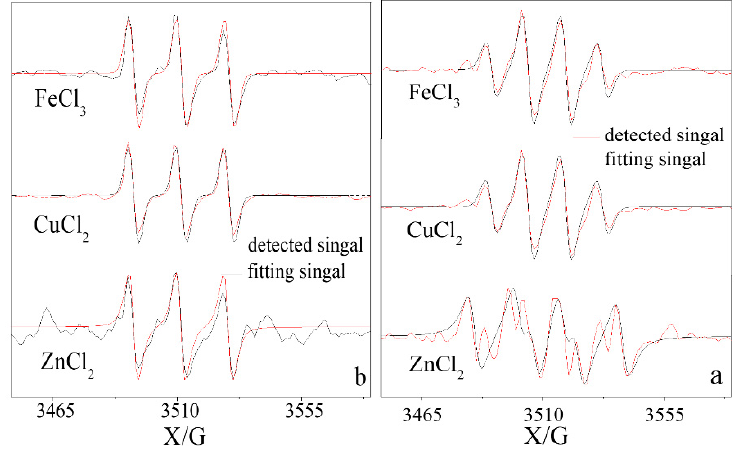
Figure 4. ESR spectra for 0.1 mM metal ion solution: ( a ) •OH and ( b ) 1 O 2 .